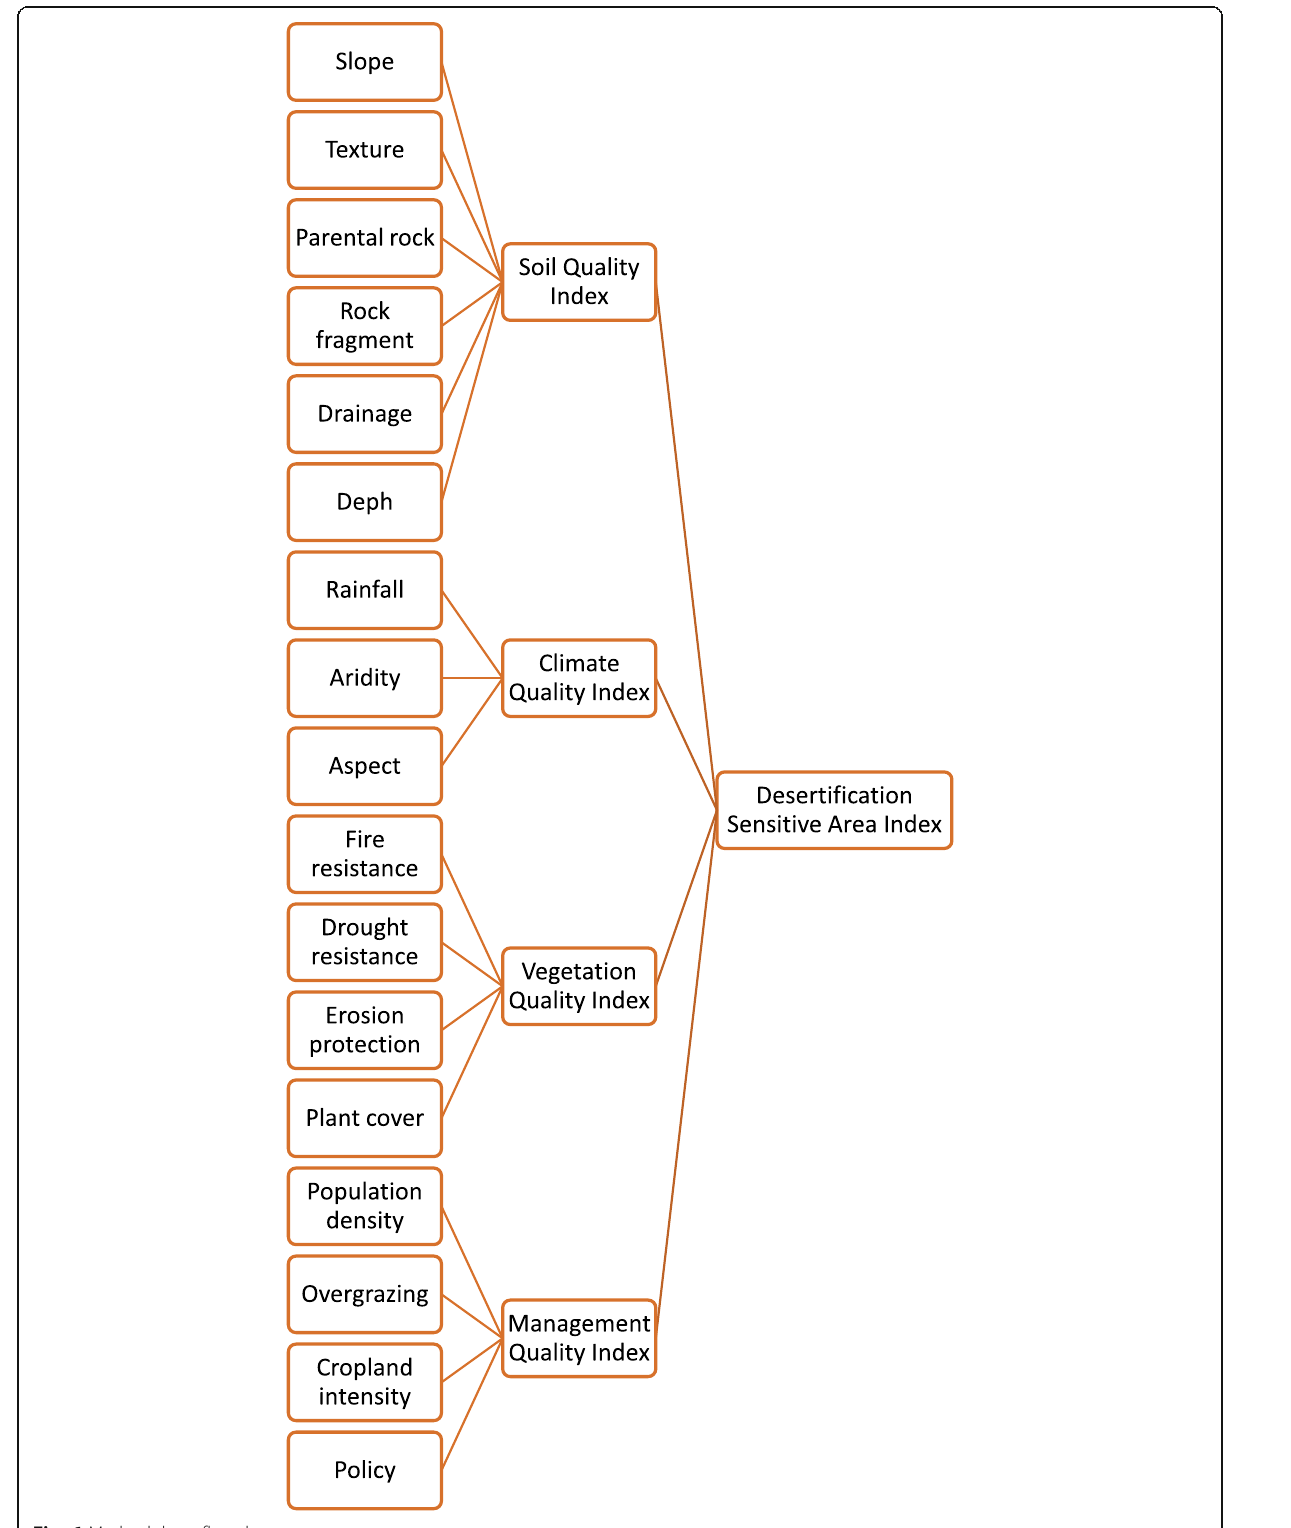
Fig. 6 Methodology